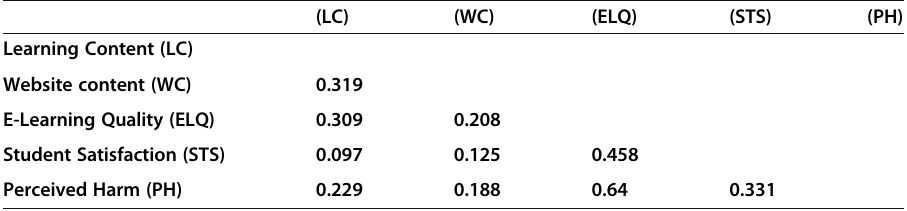
Table 4 HTMT ratio for divergent validity